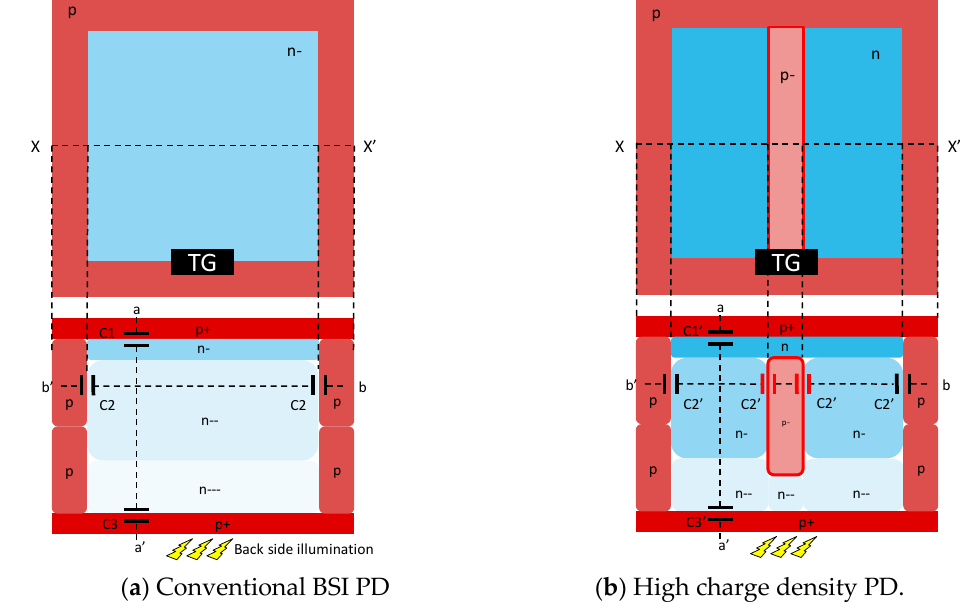
Figure 3. Top view and a cross-sectional view along X - X ’ of a conventional backside-illuminated (BSI) photodiode (PD) and the high charge density PD [14]. TG is the transfer gate.